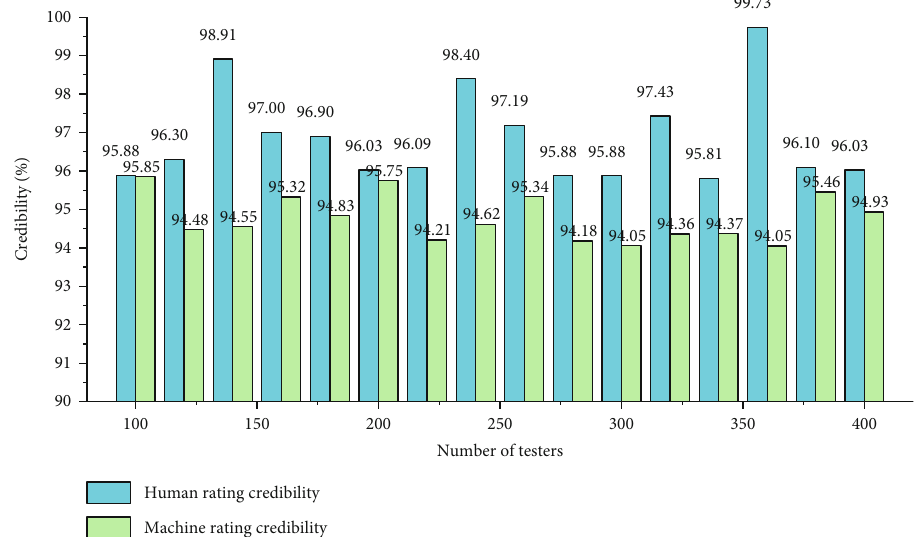
Figure 4: Distribution of human-machine